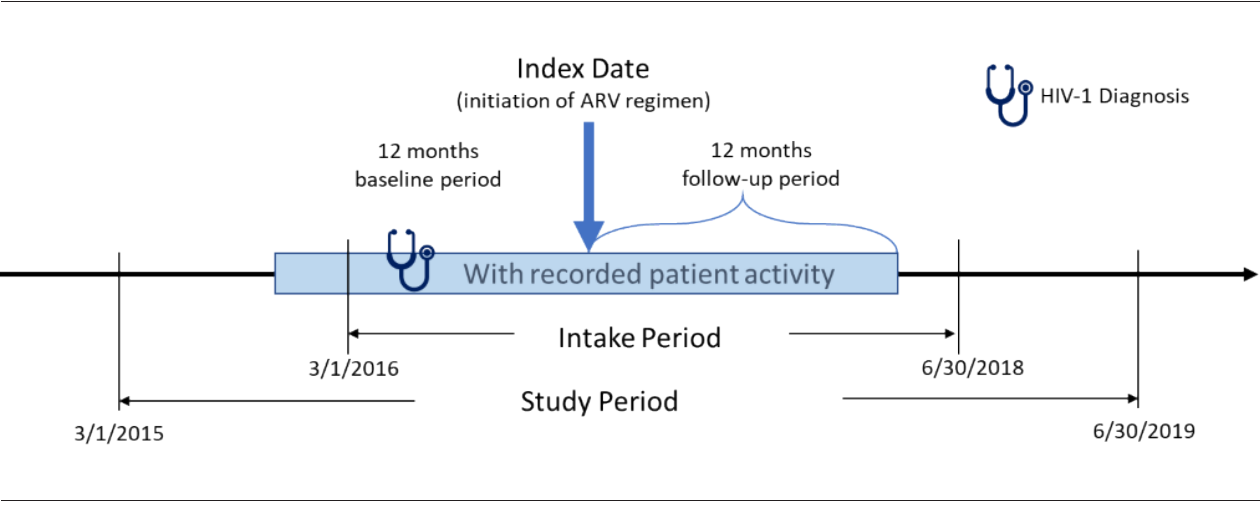
Figure 1. Study Design and